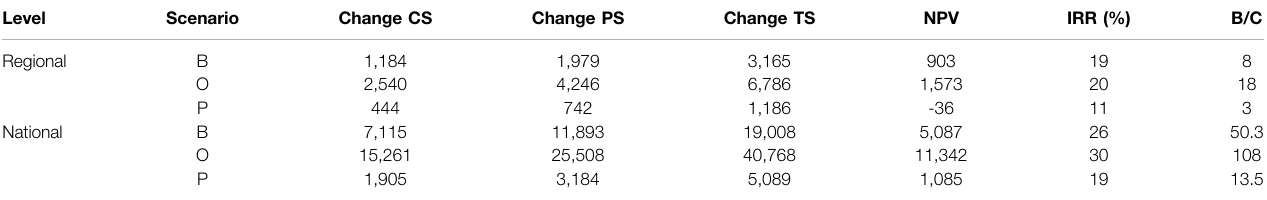
TABLE 7 | Economic surplus model results (values in thousand